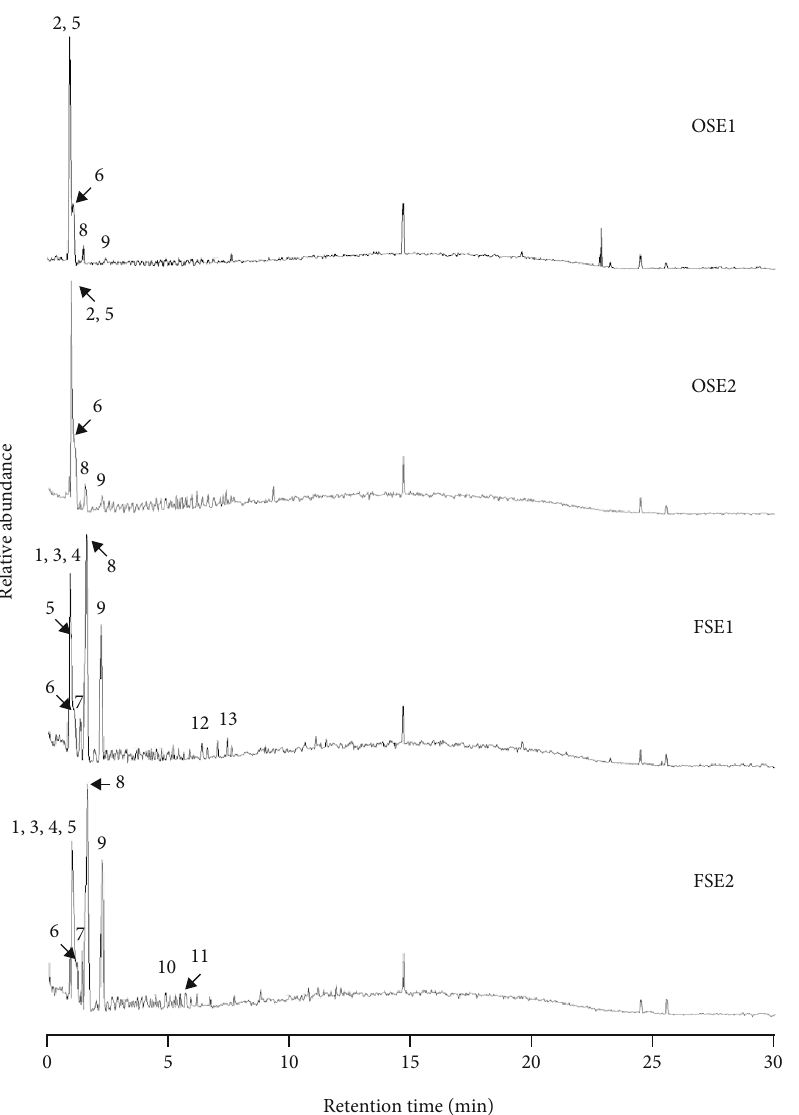
Figure 3: LC-MS/MS chromatogram of fraction < 3 kDa of water extract of old (OSE) and fermented (FSE) of P. edule seed (positive ion